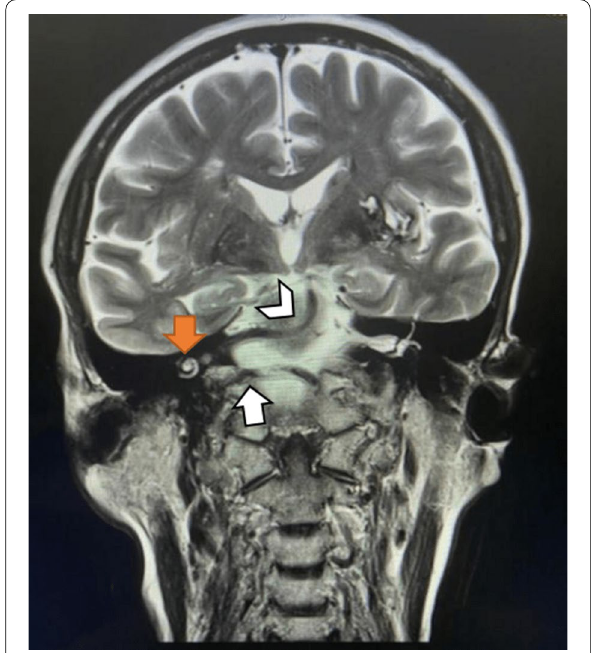
Fig. 1 Contact between facial nerve root entry zone and tortuous vertebrobasilar artery (arrow)